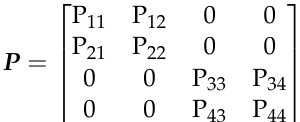
Table 5. SSA of ten aerosol models at 338 nm and 443 nm. SSA